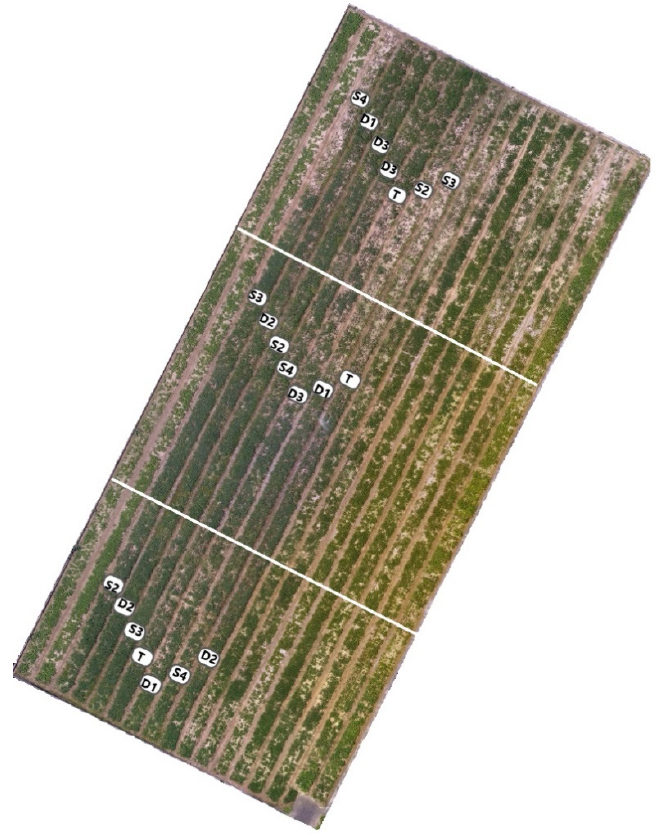
Figure 1. Peanut density plot layout.